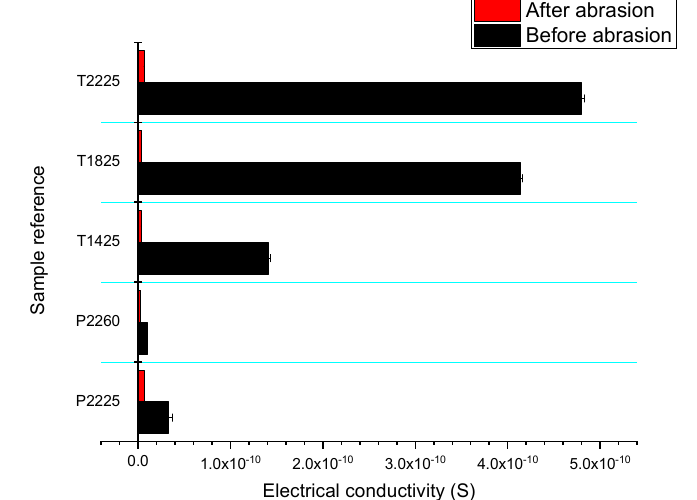
Figure 14. Electrical conductivity (S) before and after abrasion (20 K cycles) for the 3D-PPOT materials samples P2260, P2225, T1425, T1825 and T2225. P2260 is designed